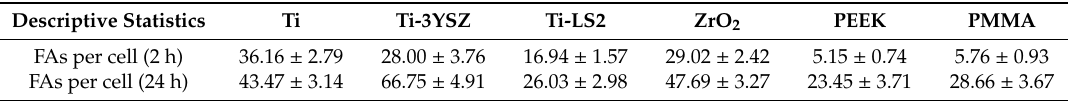
Figure 5. Histograms of HGF focal adhesions (FAs) at a di ff erent time 2 (line + fill) and 24 h (dashed line) after seeding: ( a ) Ti; ( b ) ZrO 2 ; ( c ) Ti-3YSZ; ( d ) PEEK; ( e ) Ti-LS2; ( f ) PMMA. Table 5. Descriptive statistics of all groups’ focal adhesions (FAs) per cell after 2 and 24 h (mean ± standard error of